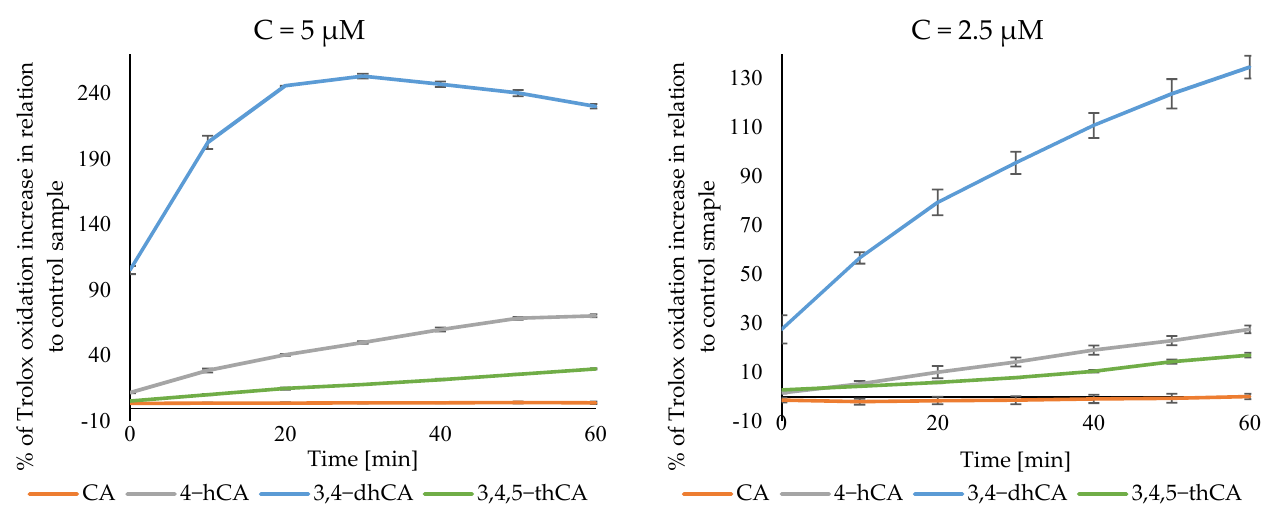
Figure 10. Pro-oxidant activity of CA and its derivatives. Figure 10. Pro  oxidant activity of CA and its derivatives.